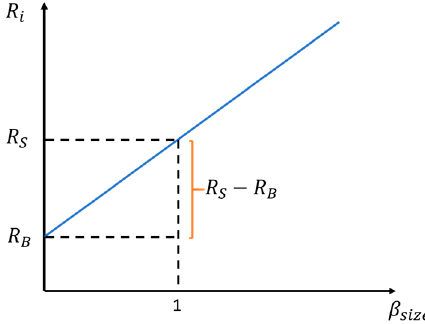
Figure A2. Positive relationship between expected return and size premium.